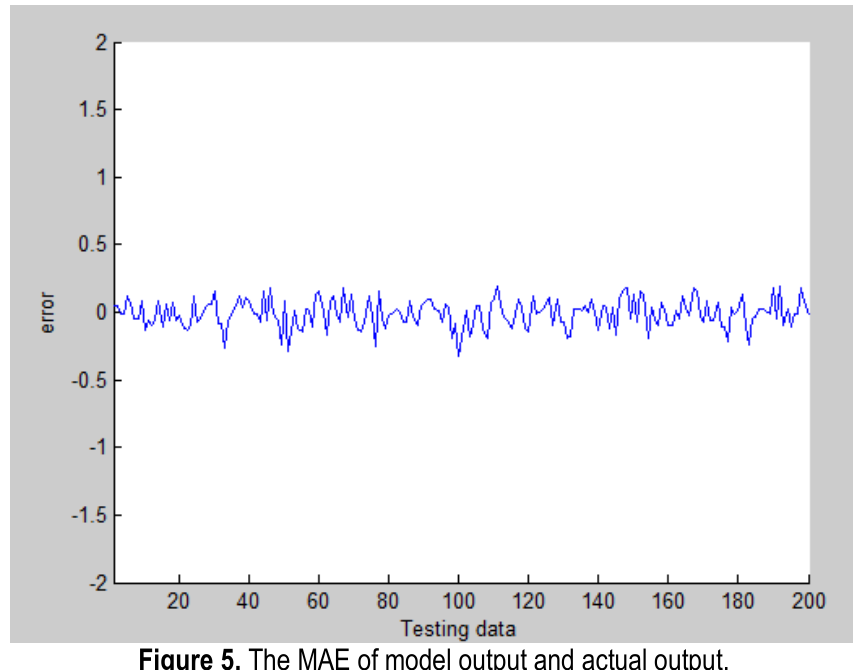
Figure 5. The MAE of model output and actual output.